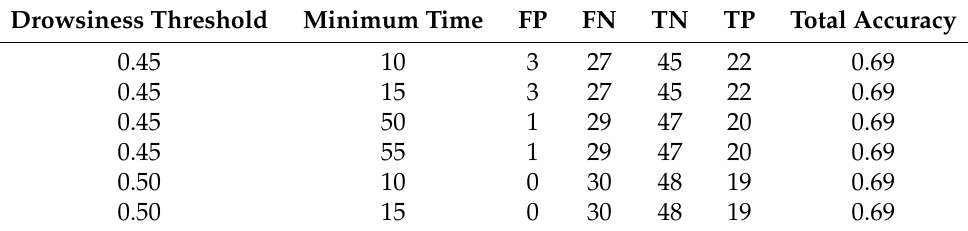
Table 7. Best results obtained by Alternative II when using the system over the training data.